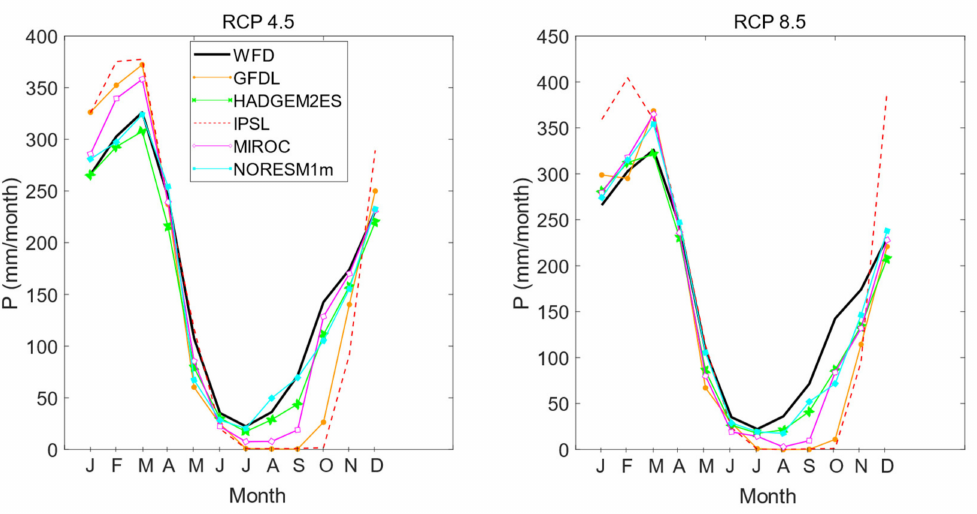
Figure 4. Mean monthly precipitation (mm/month) in the IRB for the WFD, each GCM, and both RCP scenarios.